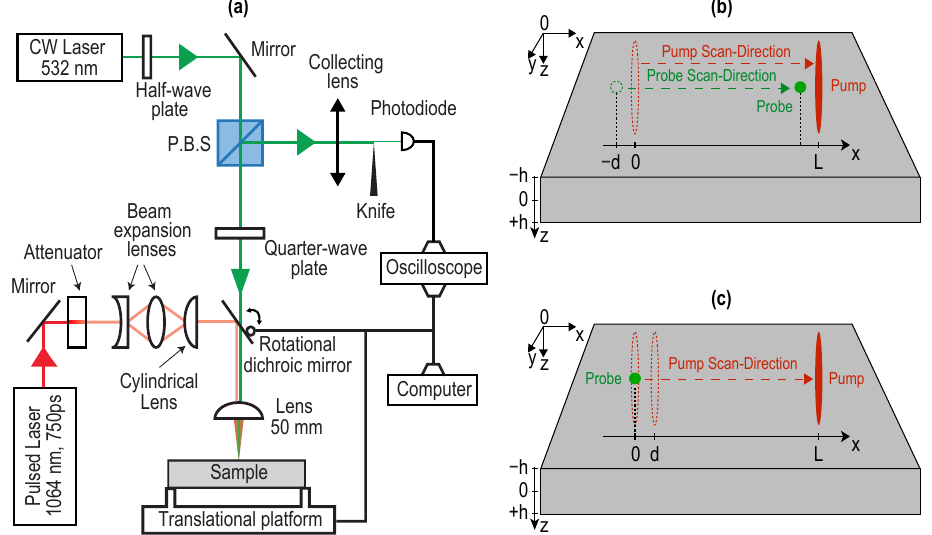
Figure 2. ( a ) Experimental setup. ( b , c ) Illustration of the two scanning configurations used: ( b ) the rotational mirror is fixed with d = 20 µm, and then the plate is moved along x -axis; ( c ) the plate is fixed, and the mirror